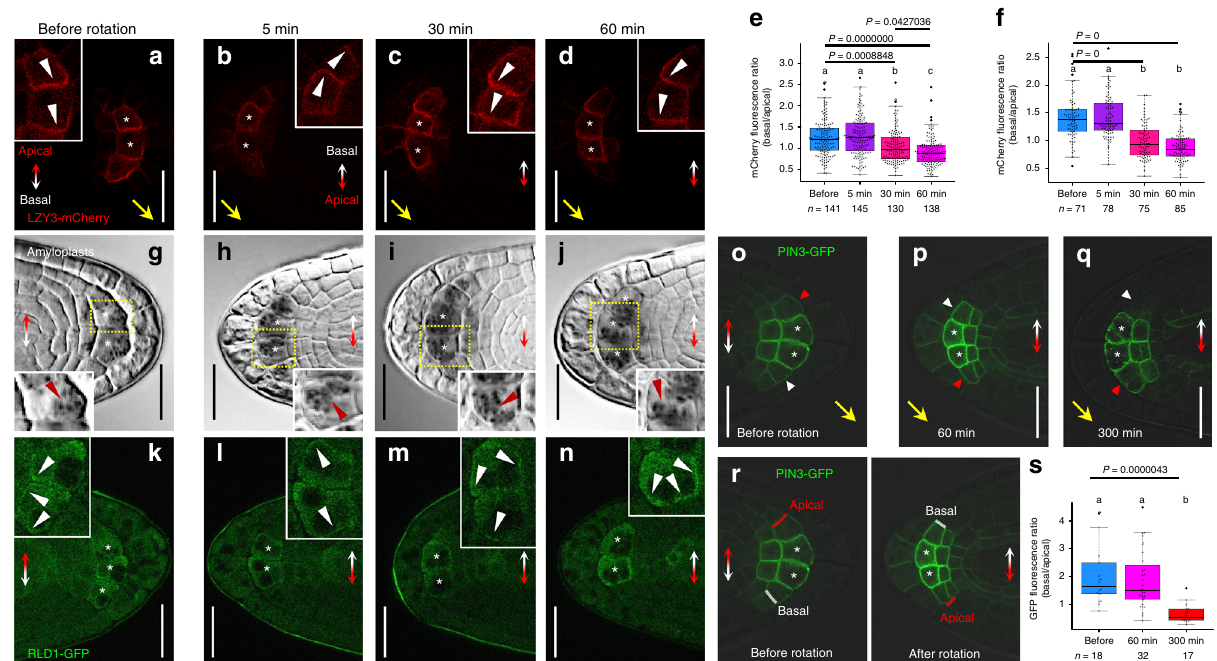
Fig. 6 Asymmetric localization of LZY3-mCherry, RLD1-GFP, and PIN3-GFP to the direction of gravity. a – d The localization of LZY3-mCherry in the LR tips of 8-day-old lzy1 lzy2 lzy3 seedlings harboring LZY3p:LZY3-mCherry at the stage 2 before rotation ( a ) and at 5 min ( b ), 30 min ( c ), and 60 min ( d ) after 180° rotation. White and yellow arrowheads indicate polarized LZY3-mCherry localization and the direction of gravity estimated from the growth orientation of LR tips, respectively. Double-headed arrows show the apical-basal axis of the plant body. Asterisks indicate central columella cells. e , f Comparison of asymmetric LZY3-mCherry localization in columella cells ( e ) and central columella cells ( f ) in LR tips at stage 2 before and after 180° rotation. Median and quartile values are provided by the central line and box boundaries. Whiskers show min to max values. g – j The position of amyloplasts in columella cells of LRs of 8-day-old lzy1 lzy2 lzy3 seedlings harboring LZY3p:LZY3-mCherry before and after 180° rotation. Brown arrowhead indicates a biased distribution of amyloplasts in columella cells. k – n The localization of RLD1-GFP in LR tips of 8-day-old seedlings harboring RLD1p:RLD1- GFP before and after 180° rotation. o – q The localization of PIN3-GFP in the LR tips of 8-day-old seedlings harboring PIN3p:PIN3-GFP before and after 180° rotation. Arrowheads indicate lateral columella cells, adjacent to central columella cells (red, apical fl ank; white, basal fl ank). r Measurement of PIN3-GFP fl uorescence intensity at lateral plasma membrane domains of columella cells adjacent to central columella cells at the basal fl anks (white) compared with those at the apical fl anks (red) in LR tips of 8-day-old seedlings harboring PIN3p:PIN3-GFP . s Comparison of asymmetric localization of PIN3-GFP in the LR tips of 8-day-old seedlings harboring PIN3p:PIN3-GFP before and after 180° rotation. n , sample number of three biologically independent experiments ( e , f , s ). Different letters in e , f , s indicate statistical differences (Tukey – Kramer, P < 0.05). Source data for e , f , and s are provided as a Source Data fi le. Scale bars, 20 μ